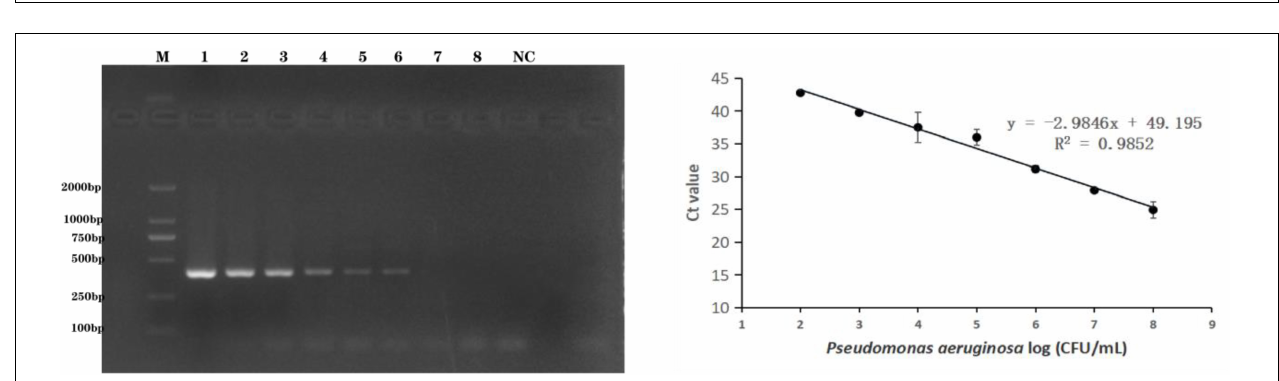
FIGURE 3 | Assessment of interference with the real-time PCR-based detection of P. aeruginosa serogroup G by co-infection with other serogroups. Detection of P. aeruginosa serogroup G (4.0 × 10 4 CFU/mL) in the presence of P. aeruginosa serogroup D (0, 4.7 × 10 2 CFU/mL, 4.7 × 10 4 CFU/mL, 4.7 × 10 6 CFU/mL, 4.7 × 10 8 CFU/mL, respectively) (3.1) and serogroup F (0, 2.4 × 10 2 CFU/mL, 2.4 × 10 4 CFU/mL, 2.4 × 10 6 CFU/mL, 2.4 × 10 8 CFU/mL, respectively) (3.2).